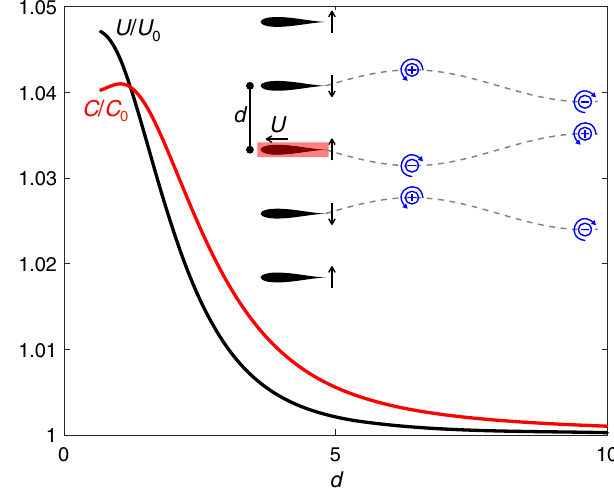
FIG. 4. Speed-up and cost of transport in a phalanx. The phalanx formation consists of infinitely many swimmers equally spaced by a distance d in the lateral direction, flapping in antiphase with respect to their neighbors. Black arrows indicate the swimmers ’ instantaneous vertical velocity. Dashed lines indicate the swimmers ’ trajectories, with associated shed vortices (blue). The speed (black curve) and cost of transport (red curve) evidently decrease as the lateral distance d between swimmers is